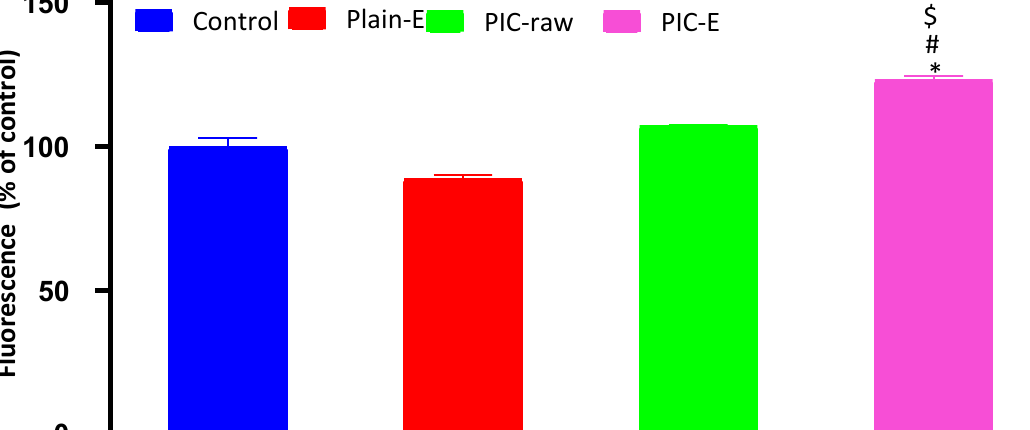
Figure 12. Effect of PIC-E on ROS generation in HCT 116 cells. Cells were incubated for 24 h with plain-E, PIC-raw (0.1 µM), or PIC-E (equivalent to 0.1 µM PIC) * Significantly different from control at p < 0.05. # Significantly different from Plain-E at p < 0.05. $ Significantly different from PIC-raw at p < 0.05.